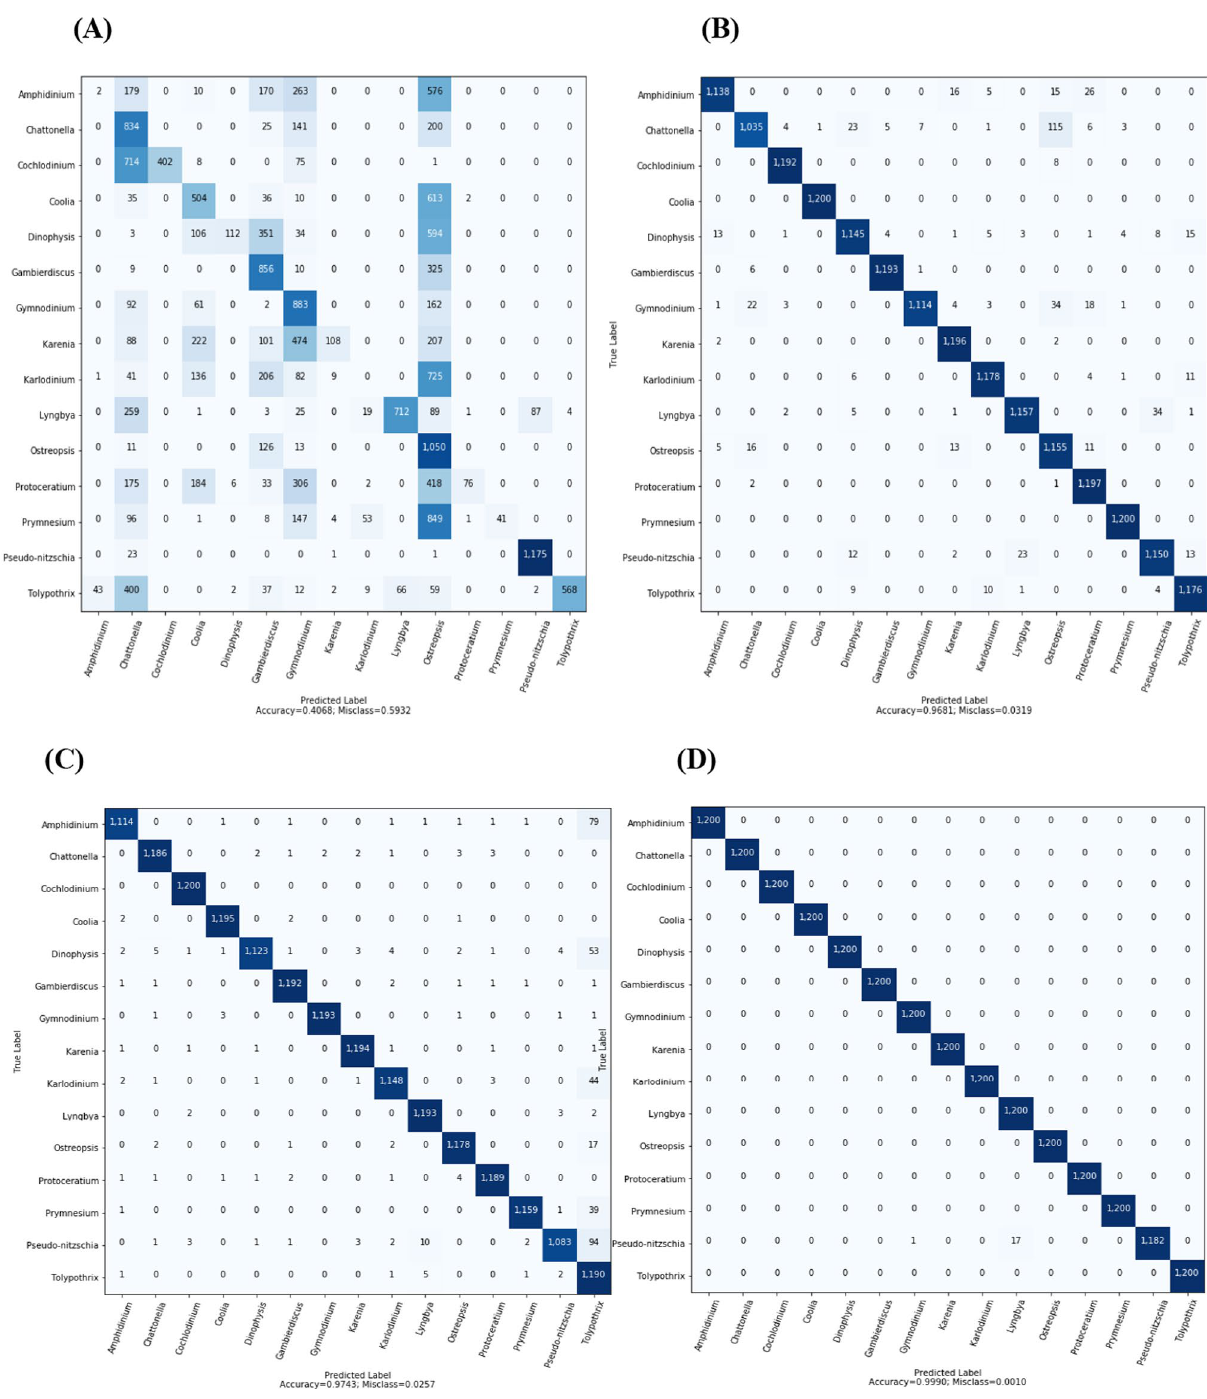
Fig. 3 Confusion matrices for CNN models— A MobileNetV-2, B VGG-16, C AlexNet, and D Modified